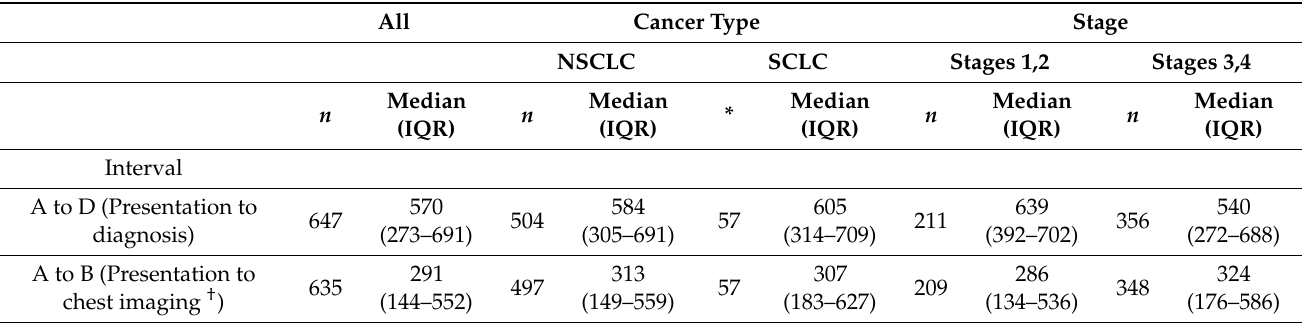
Table 3. Duration of time intervals from first symptomatic presentation, chest imaging, specialist visit, diagnosis, and initiation of treatment for lung cancer *.